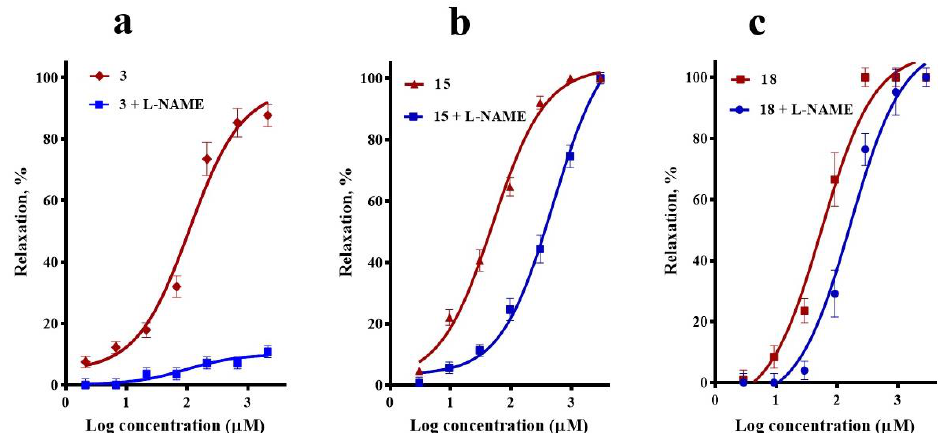
Figure 4. Vasodilatory effect of ( a ) corosolic acid ( 3 ), ( b ) meso -dihydroguaiaretic acid ( 15 ), and ( c ) 5,8,4′-trihydroxy-3,7-dimethoxyflavone ( 18 ) in the absence (control) and presence of L-NAME (100 µM). Analysis by one-way analysis of variance (ANOVA) was made between the curves of each compound in the absence and presence of N G -nitro-l-arginine methyl ester (L-NAME) followed by a